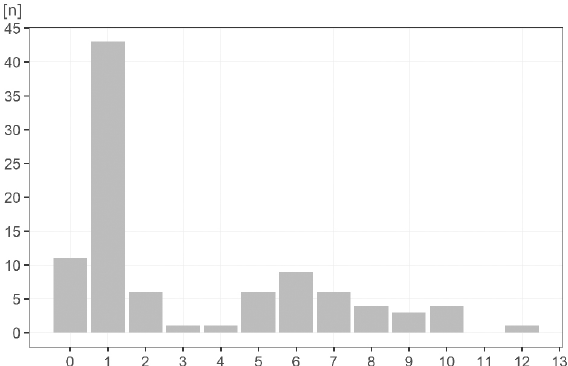
Fig. 5. Number of LULC classes employed in the